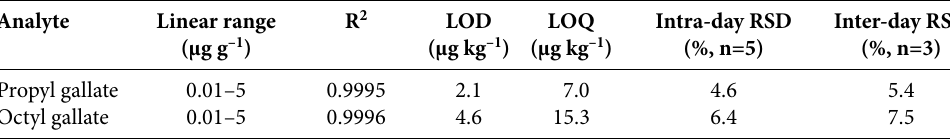
Table 2. Quantitative features of VA-DES-LLME method combined with LC-UV. Analyte